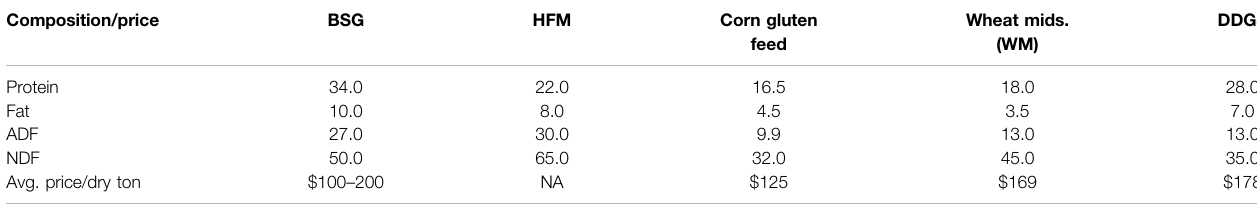
TABLE 3 | BSG, HFM, and competitive fi ber energy feed. Compositional analysis is provided based on dry matter basis. Composition/price